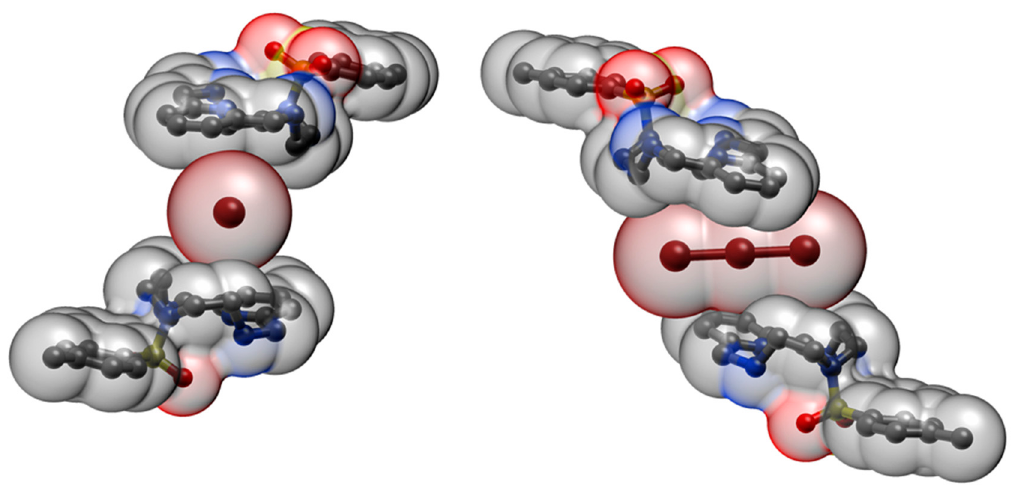
− sandwiching between adjacent (H